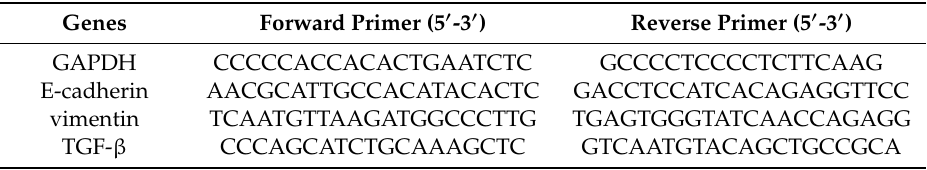
Table 1. List of oligonucleotides used for quantitative analysis of gene expression by quantitative real-time PCR